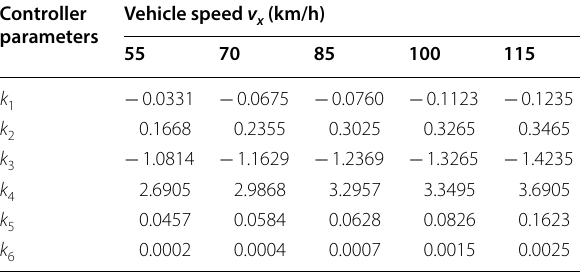
controller of local subsystems ∞